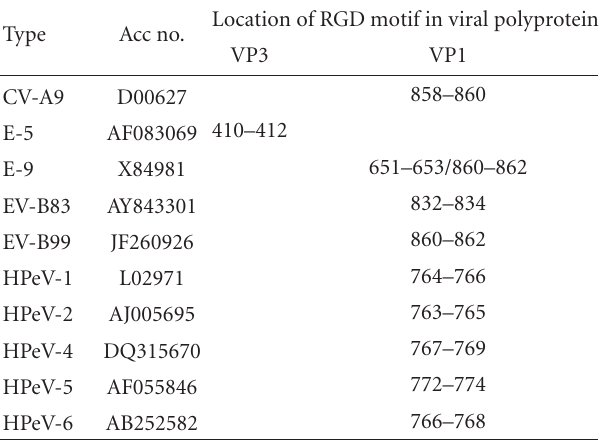
Table 1: RGD motif(s) identified in picornaviral capsid